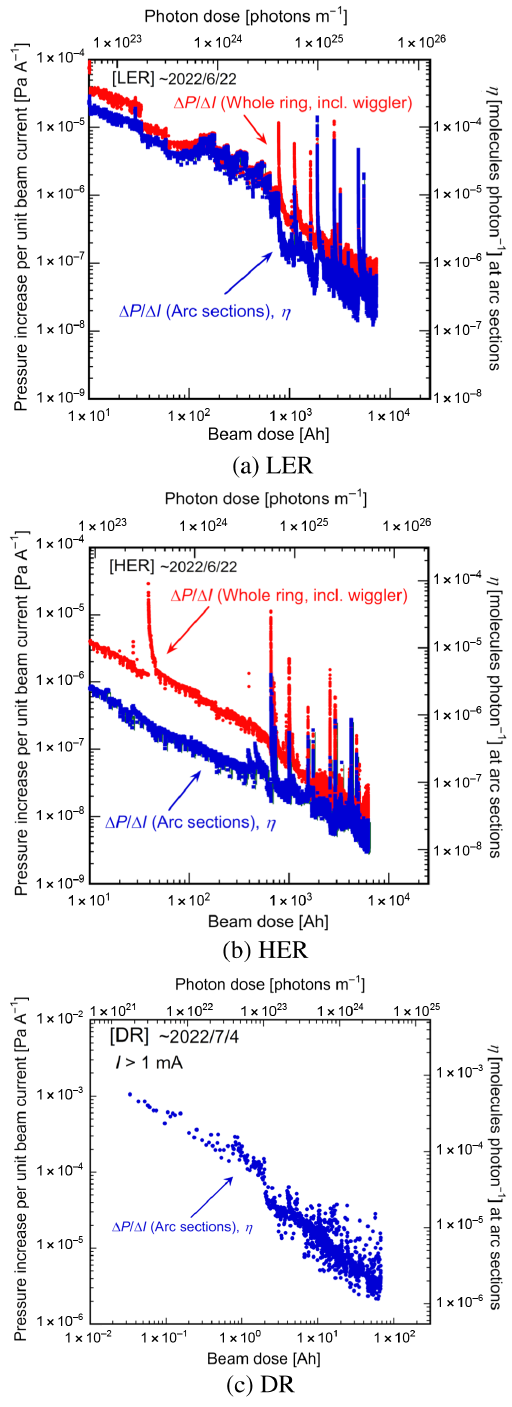
FIG. 7. Pressure increase per unit beam current ( Δ P= Δ I ) of the whole rings and arc sections as a function of the beam dose, and η of arc sections as a function of photon dose for (a) LER, (b) HER, and (c) DR from